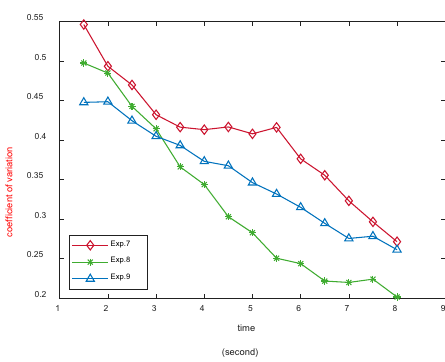
Fig. 9. The curve of variation coefficient.